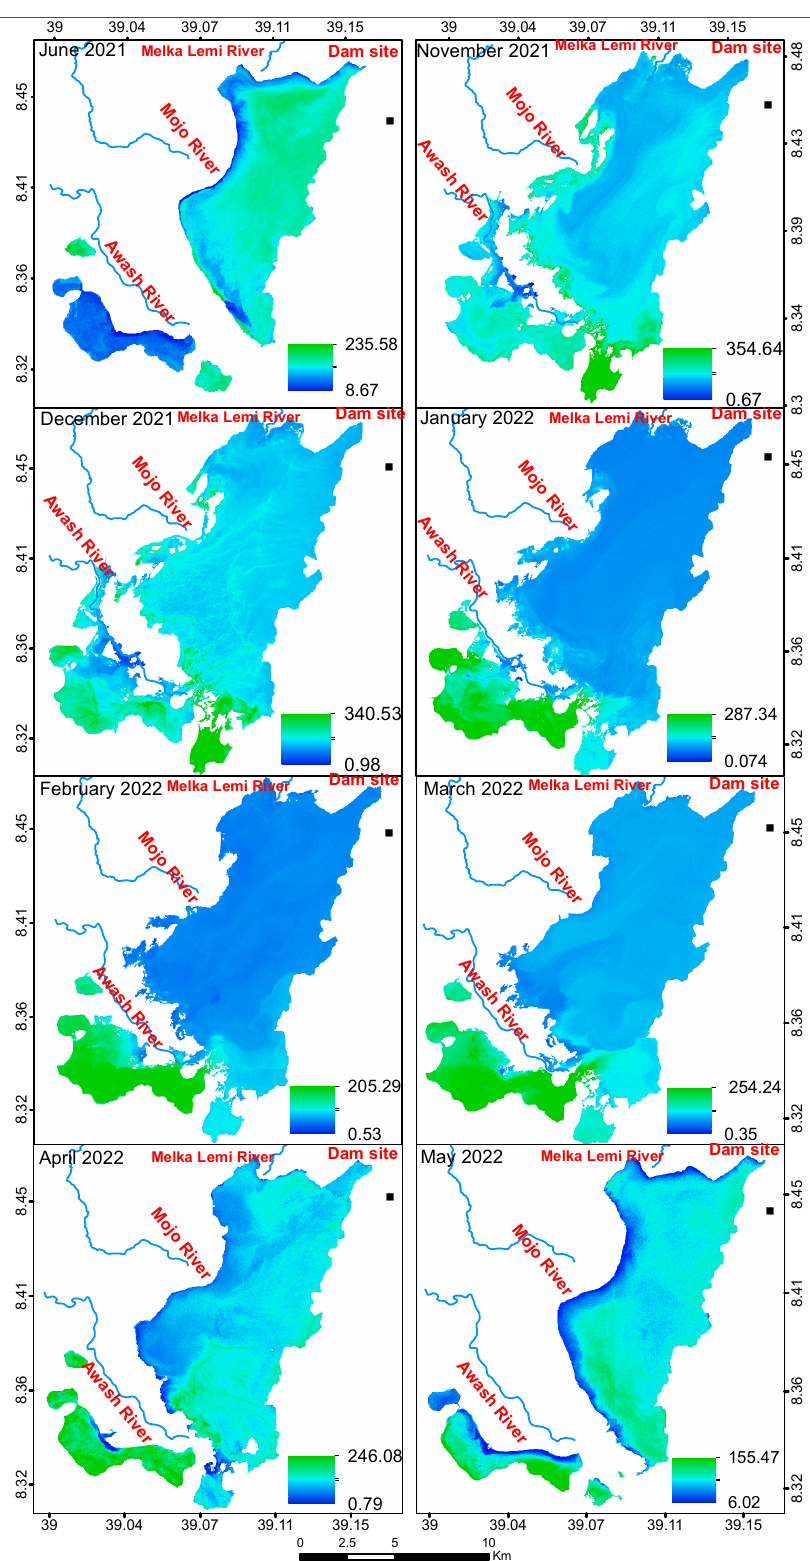
Figure A1. Monthly chlorophyll a (in µg/L) spatial distribution.